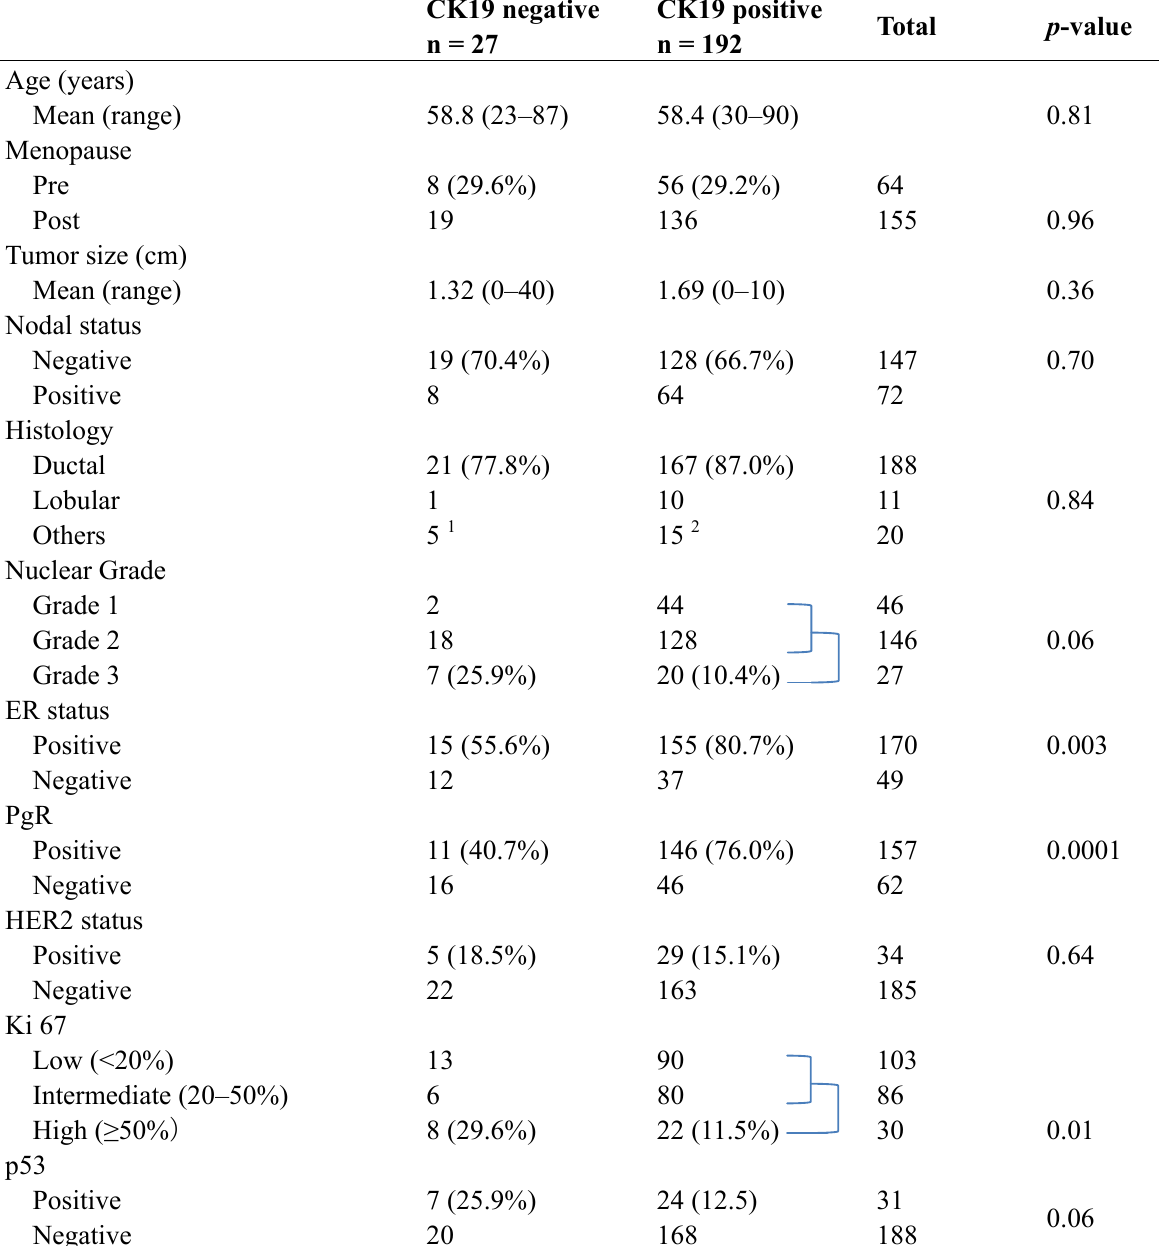
Table 2. CK19 expression status and clinico-pathological